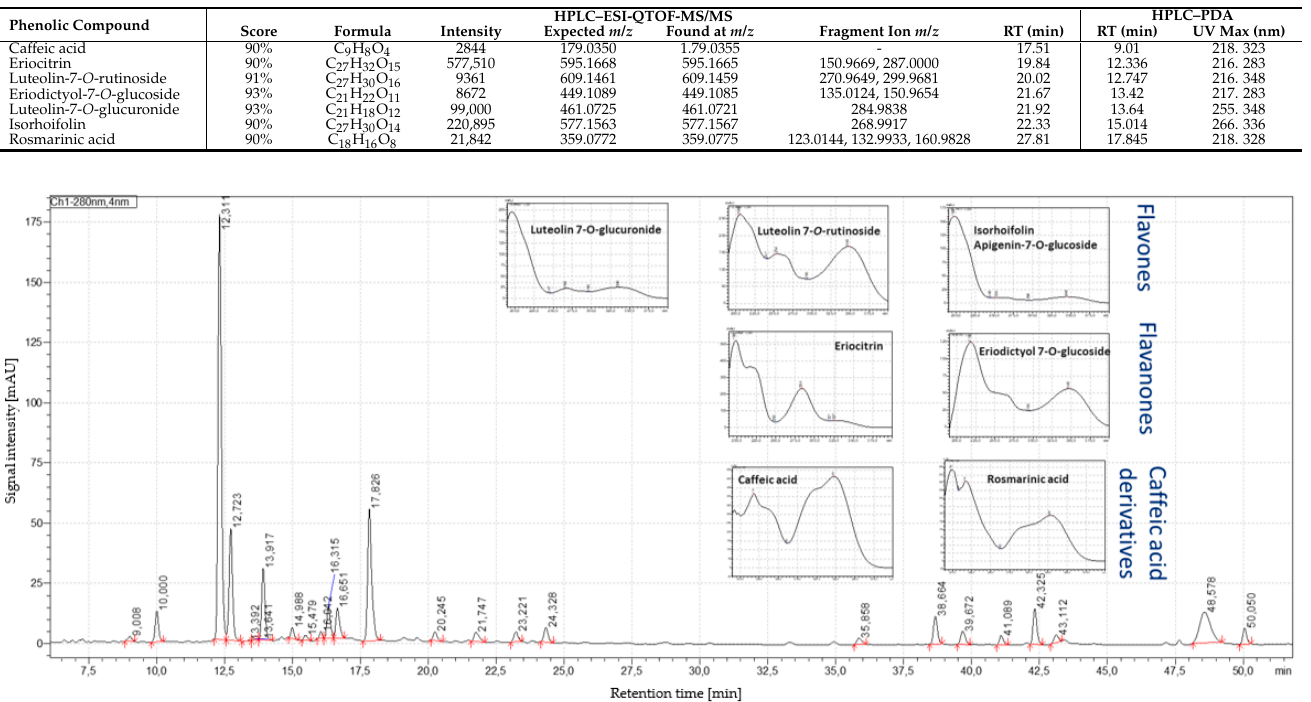
Figure 3. HPLC–PDA profile at 280 nm exemplarily for the peppermint leaf sample L2 from Europe, showing caffeic acid (9.01 min), eriocitrin (12.31 min), luteolin-7- O -rutinoside (12.72 min), eriodictyol-7- O -glucoside (13.39 min), luteolin-7- O -glucuronide (13.64 min), luteolin-7- O -glucoside (13.92 min), isorhoifolin (14.98 min), and rosmarinic acid (17.83 min).